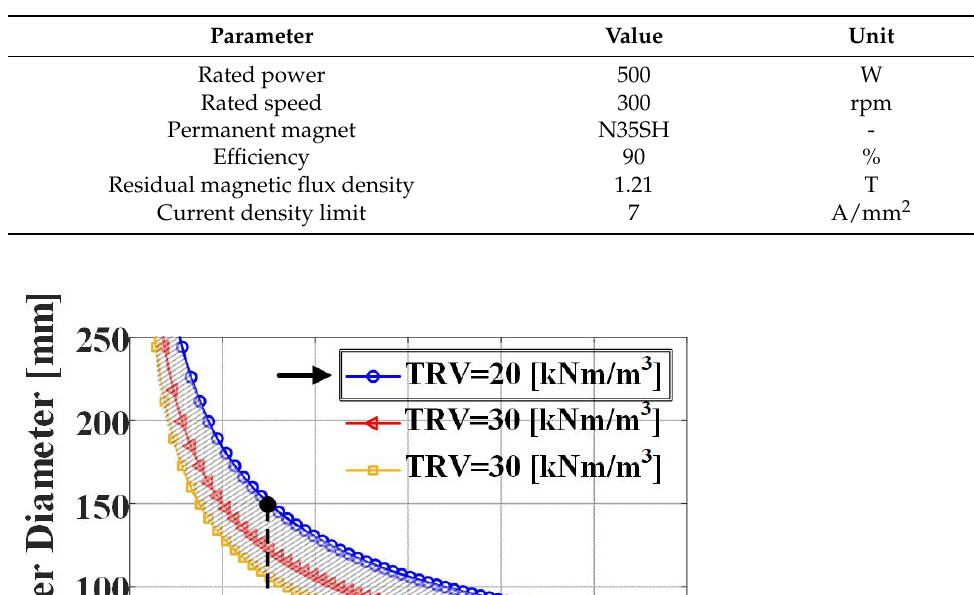
Table 1. Design requirements.